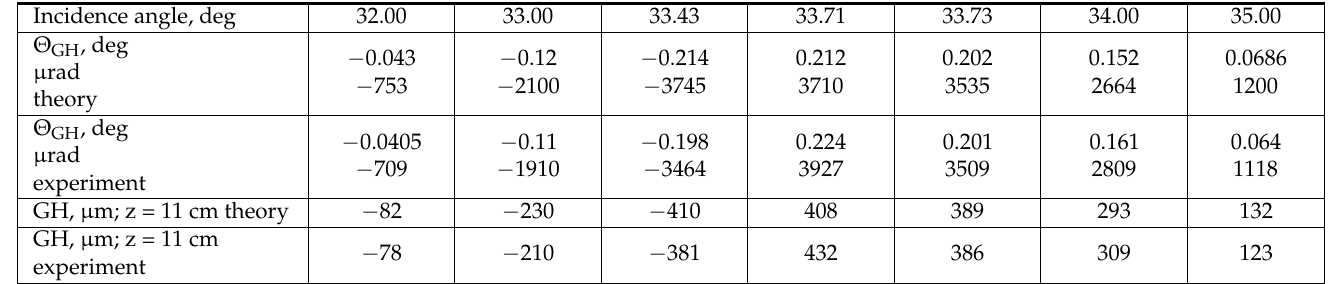
Table 1. Angular GH shifts at different incidence angles. h = 80 nm, FWHM = 32 µ m. Incidence angle, deg 32.00